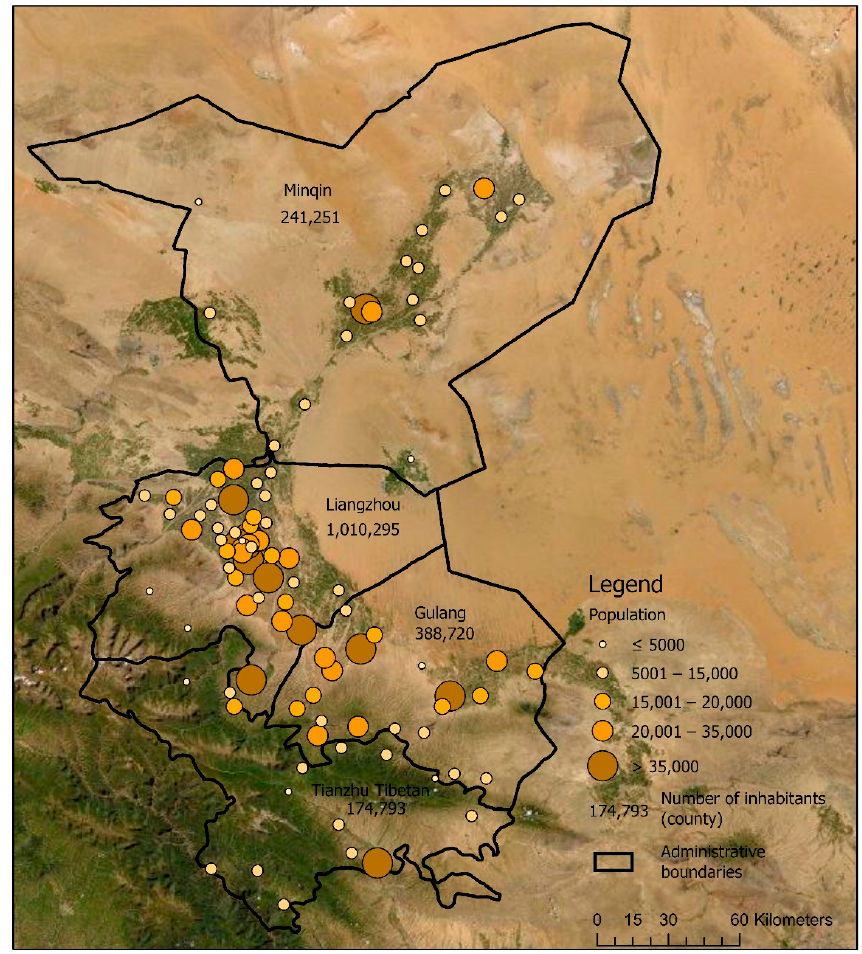
Figure 3. Population in Wuwei and its counties (own map, administrative boundaries are based on Database of Global Administrative Areas (GADM data) data and